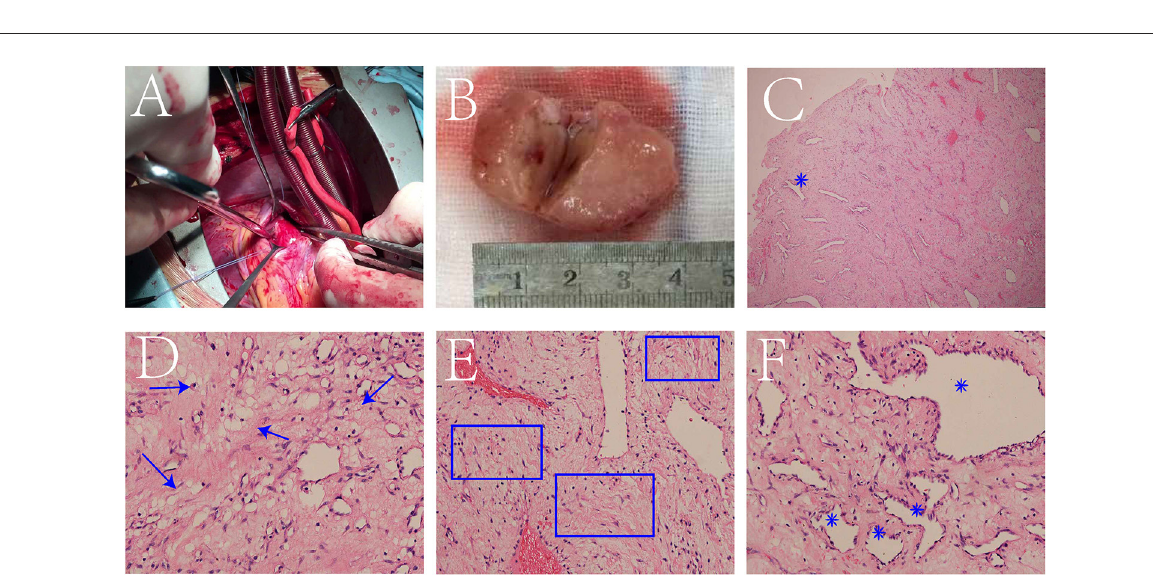
FIGURE2 A tumor was found in the anterior wall of the right ventricle (A) . The specimen is a pale-yellow pedunculated ball with a texture close to myocardial tissue, and the cut surface with the “fish flesh” like texture (B) . Low magnification of the hematoxylin-eosin (HE) stained